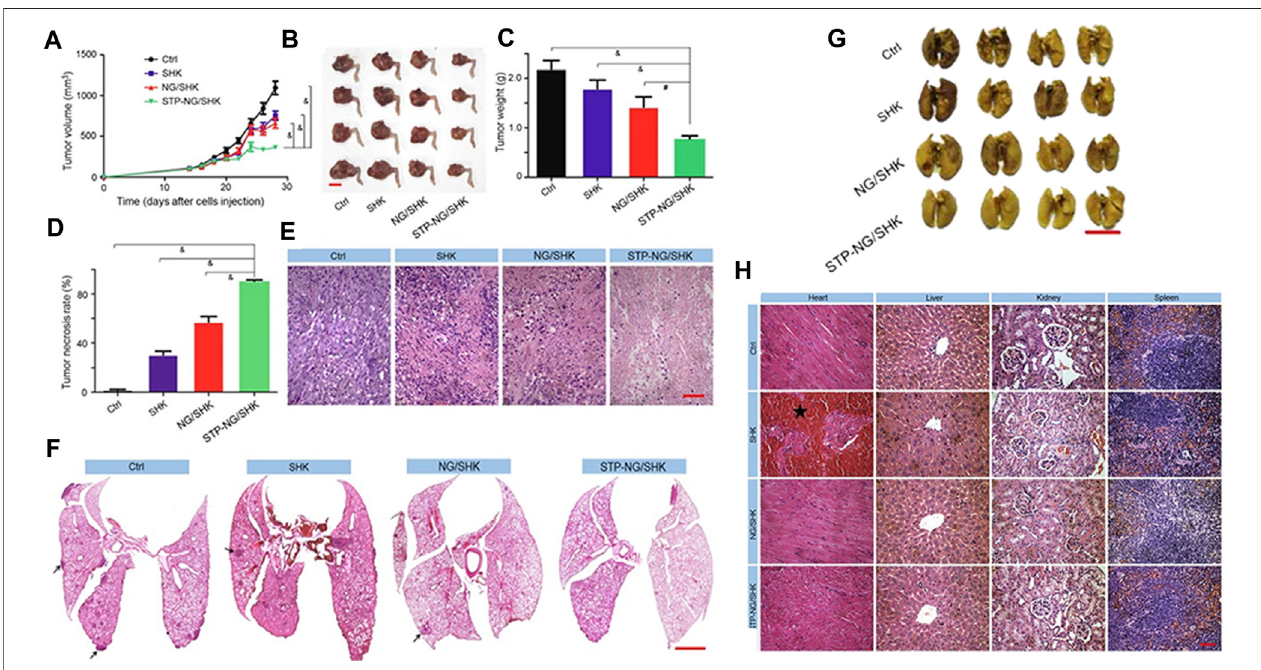
FIGURE6| Animalexperimentsregardingtumorinhibition bythenanogels(LiS.etal.,2018). (A) Tumorgrowthcurve. (B) Hindlimbtumors. (C) Averageweightof the osteosarcoma. (D) Calculationoftumor necrosissize. (E) Hematoxylin – eosinstainingoftheprimarytumor. (F) H&Estainingofthelungmetastases. (G) Appearance of the lungs in each group. (H) H&E staining of mouse